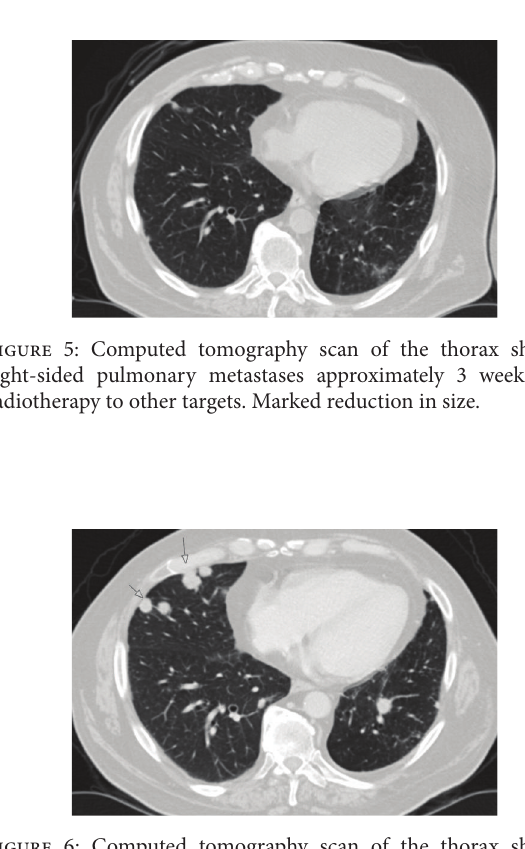
Figure 4: Time course of neutrophil leukocyte and lymphocyte counts during follow-up. The green line corresponds to the date of the computed tomography scan showing the nontargeted effect. At this time, the patient had recovered from presumably radiation- related lymphopenia. Abnormally high lymphocyte counts were never detected. In contrast, several episodes of leukocytosis occurred.